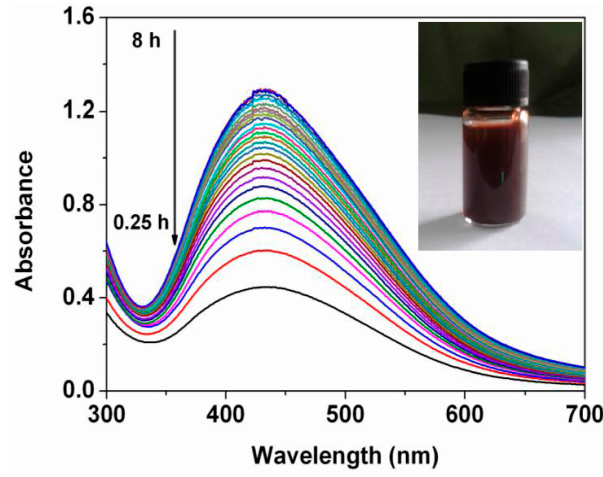
Figure 2. UV-Vis spectra of as-prepared Ag nanoparticles at different reaction time. The insert shows image of the reaction